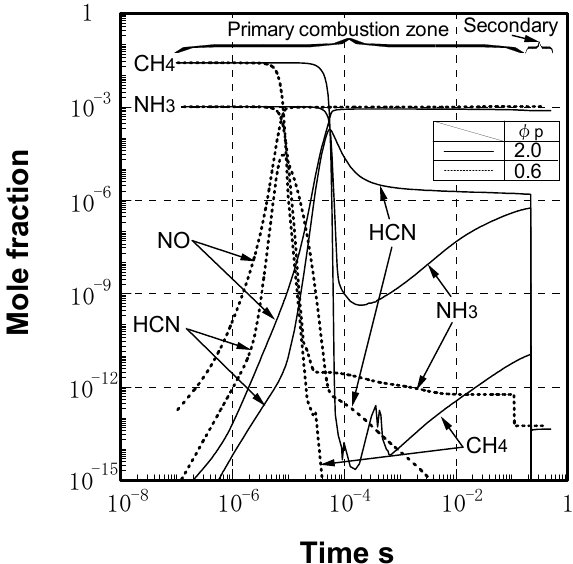
Figure 18. Mole fraction-time products, comparing φ as defined by